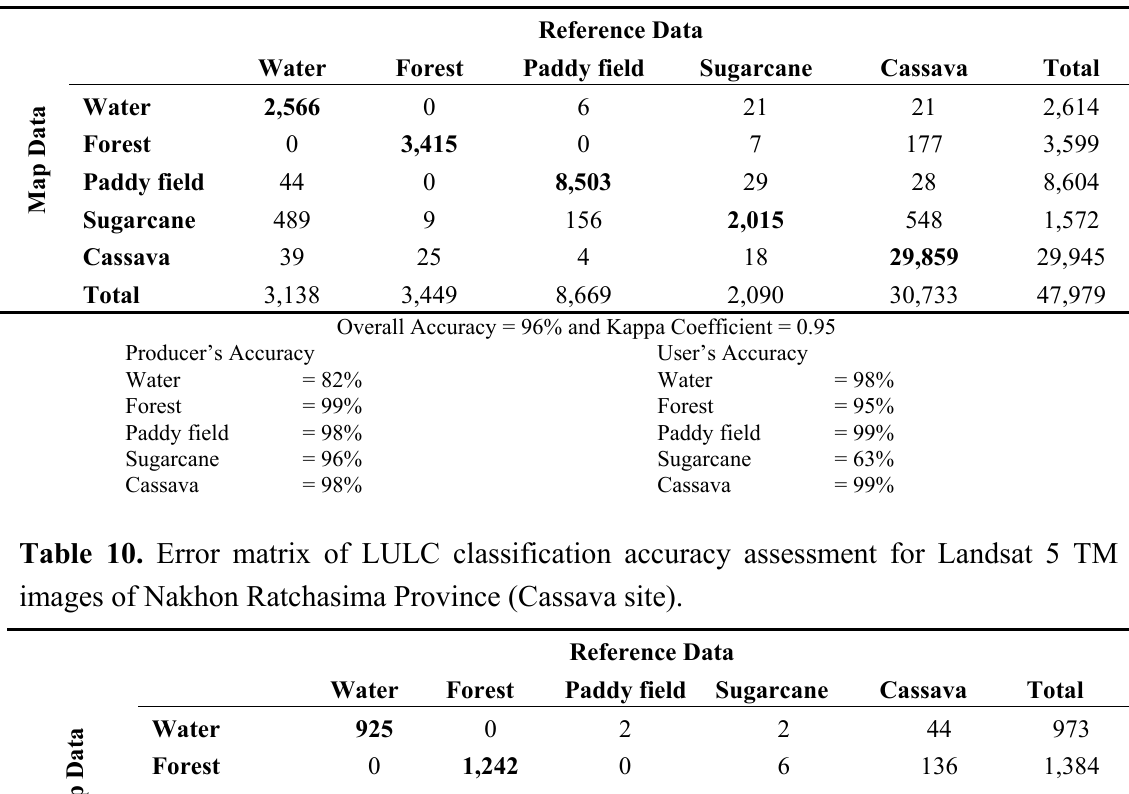
Table 9. Error matrix of landuse/landcover (LULC) classification accuracy assessment for THEOS images of Nakhon Ratchasima Province (Cassava site).